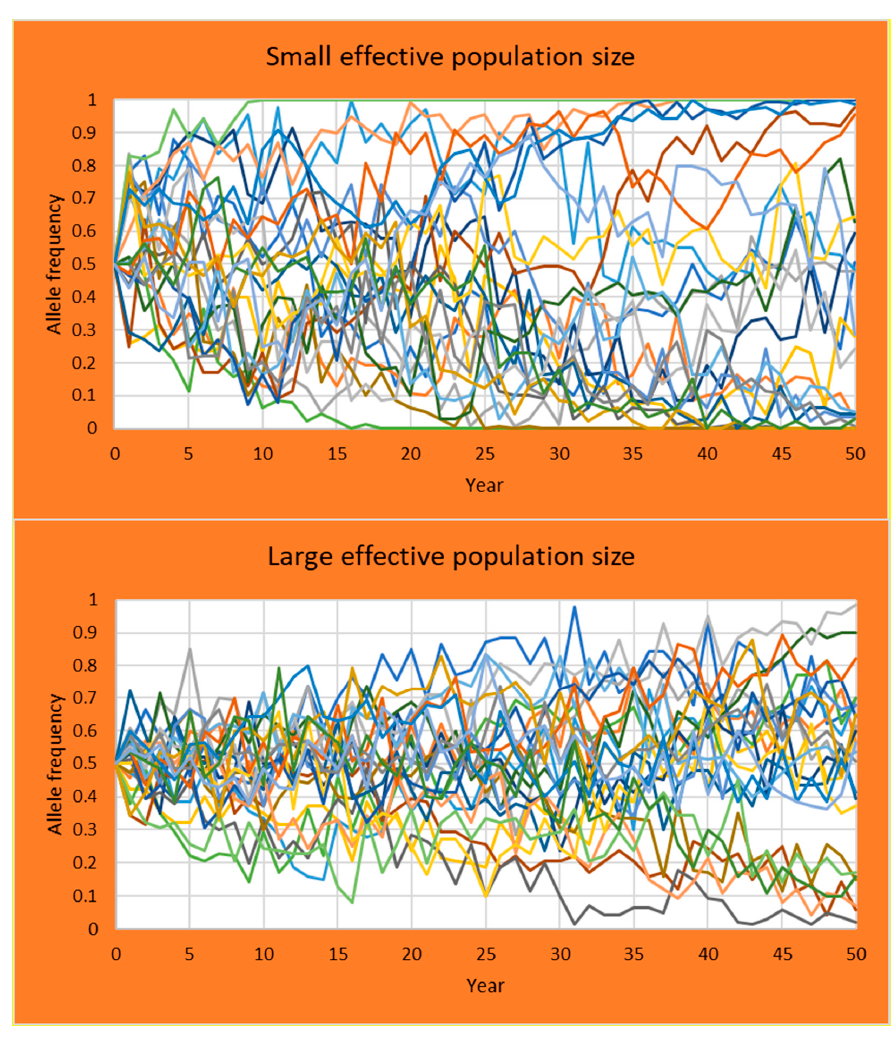
Figure 7. Output of the results for the students practical devised to understand the effect of effective population size on variation in allele frequencies. Same population was simulated twice, once with breeding dominated by a single sire producing a small effective population size (top panel), and once with all sires having an equal chance to reproduce (bottom panel). Shown is the allele frequency in each of the 25 replicates.